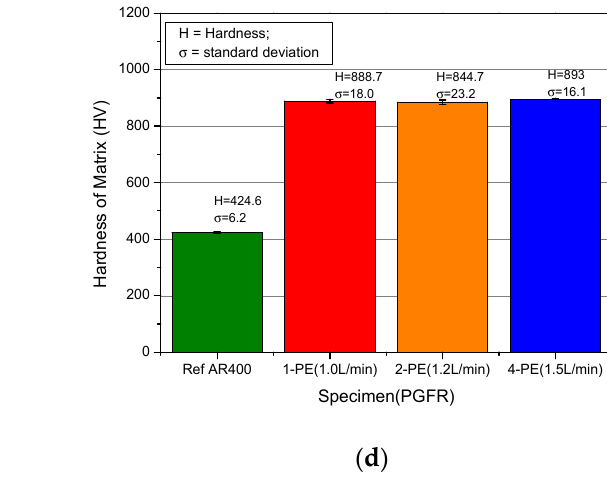
Figure 17. Comparative plots on the effects of PGFR on abrasive wear performance and hardness of surface coatings ( a , b ) effects of PGFR on the abrasive wear resistance of samples prepared with PG and PE powder MMCs, respectively ( c , d ) effects of PGFR on hardness of matrix of samples prepared with PG and PE powder MMCs, respectively. Table 10. Optimum process parameters used for sample preparation, applicable to the two MMC powders used for this